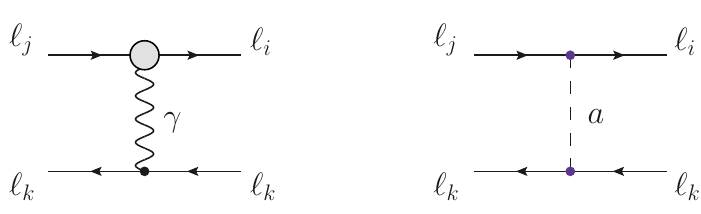
‘ i ‘ k ‘ k at loop-level (left panel) !